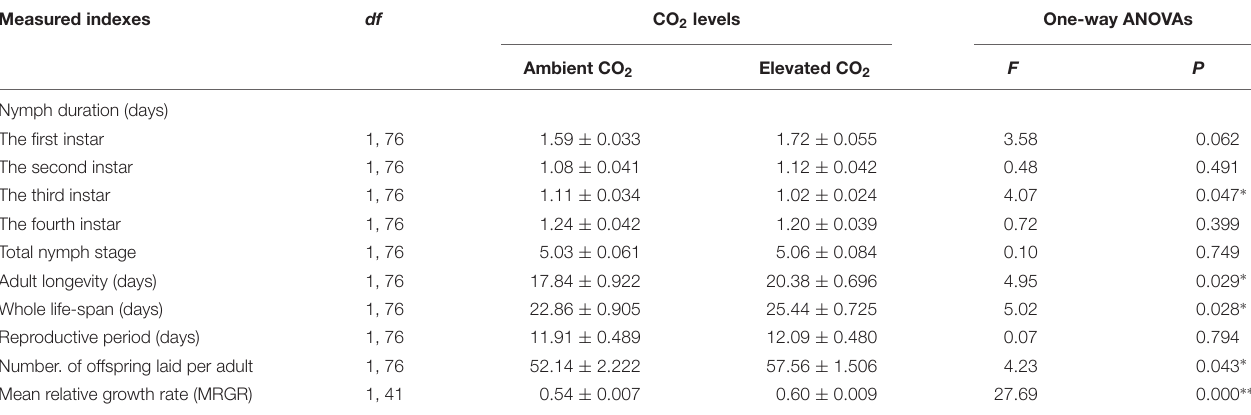
FIGURE 2 | Impacts of elevated CO 2 on the contents of different types of foliar free amino acids of cotton seedlings (Asterisks indicate a significant difference between the treatments of ambient and elevated CO 2 by the LSD test at P < 0.05). TABLE 4 | Mean ( ± SE) values of the development indexes (including nymph duration, adult longevity, and whole life span), fecundity (including number of offsprings laid per adult and reproductive period), and mean relative growth rate (MRGR) of the cotton aphid A. gossypii fed on the fully expanded leaves excised from the 35- to 60-day-old cotton seedlings grown under ambient and elevated CO 2